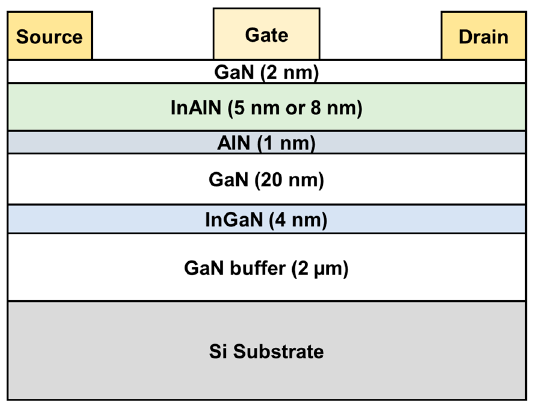
Figure 1. Schematic cross-section of the fabricated InAlN/GaN HEMT with two different InAlN bar- rier thickness (8 nm and 5 nm, respectively). barrier thickness (8 nm and 5 nm,